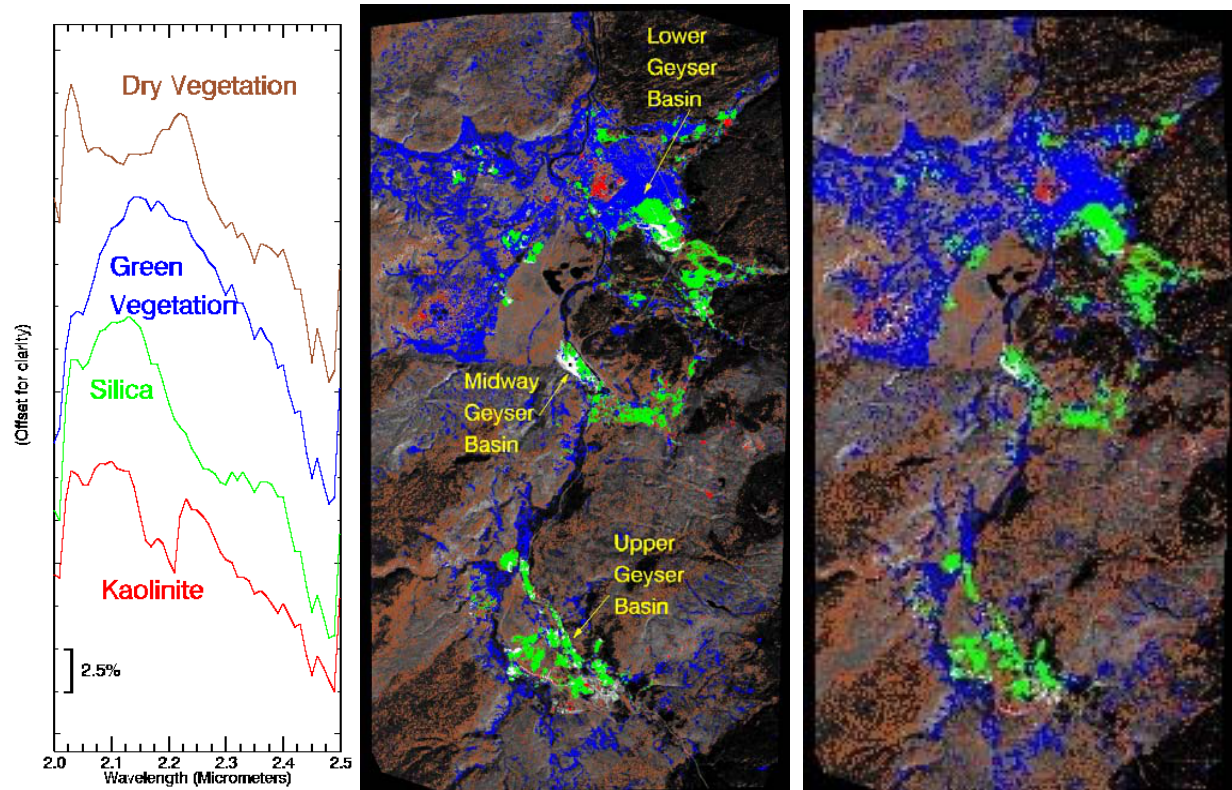
Figure 6. Left: SWIR spectral endmembers for the 1996 Firehole River 15 m HyspIRI spectrally resampled AVIRIS data. Center: 15 m mixture-tuned-matched-filtering (MTMF) spectral mapping results for the spectral endmembers shown on the left. Right: 60 m MTMF spectral mapping results for 60 m HyspIRI-simulated data. Image base is approximately 10 km. North is to the